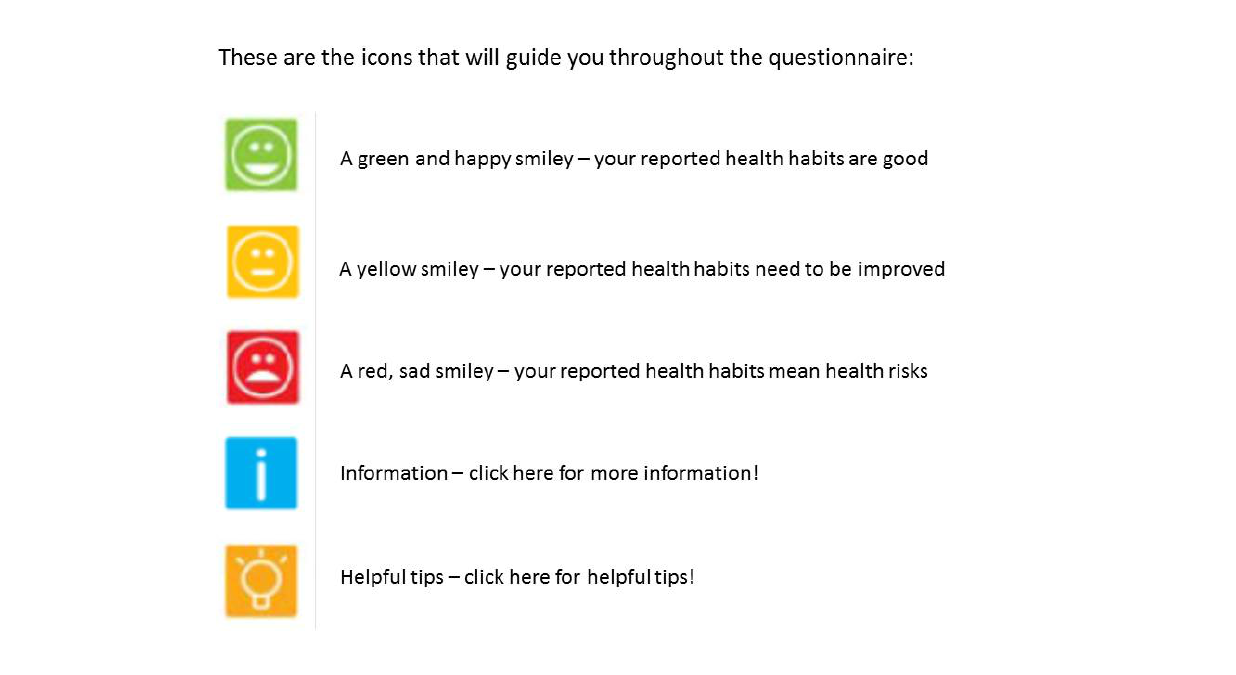
Figure 1. Screenshot of the icons used to guide the participants throughout the completion process of the